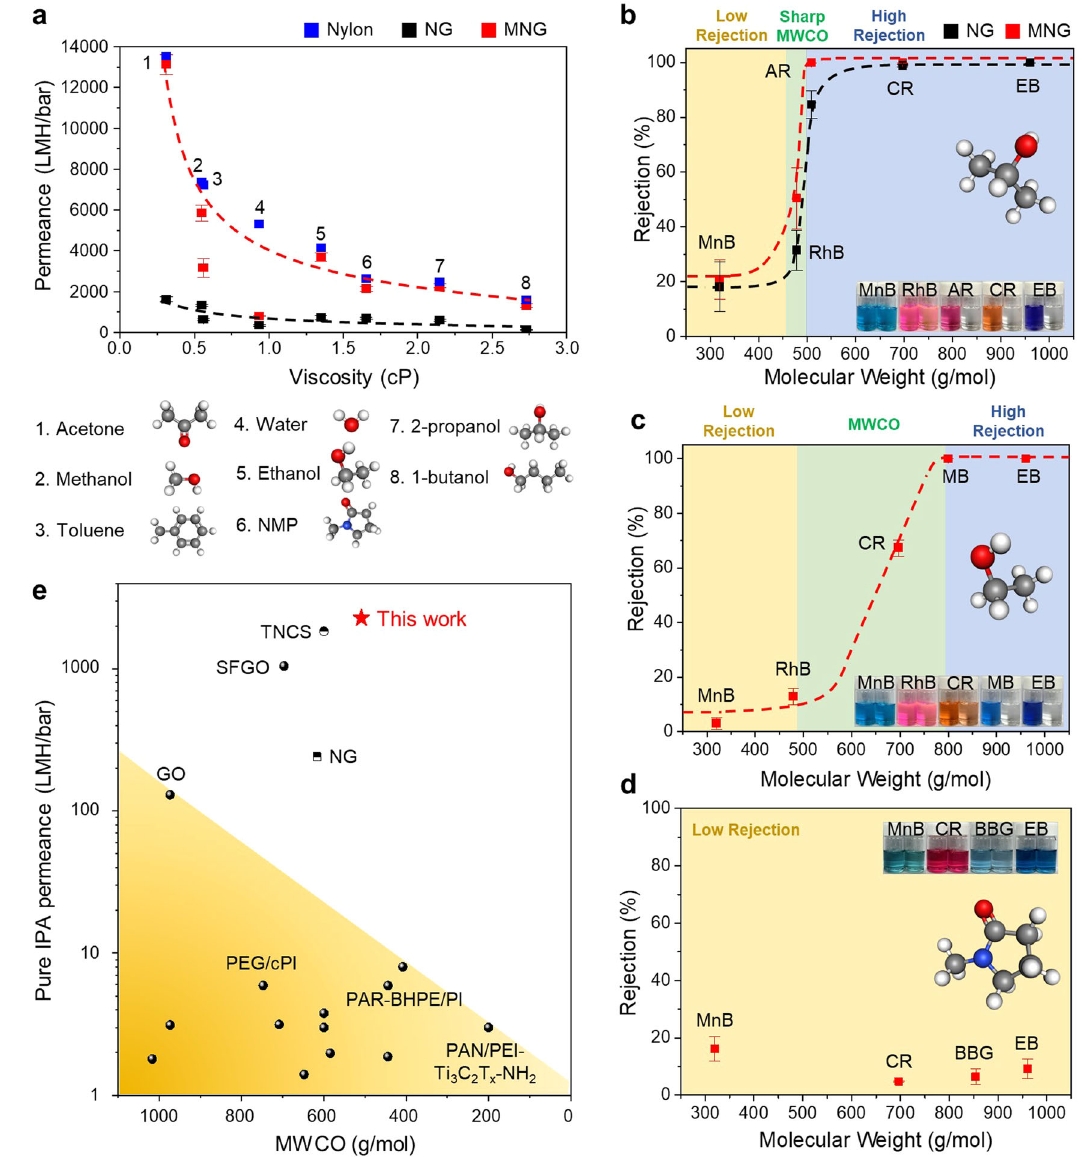
Fig. 5 | Organic solvent nano fi ltration performance of MNG membrane. a Permeance of pure organic solvents across 200nm thick NG and MNG mem- branes as a function of viscosity. b – d Nano fi ltration performance of MNG mem- branestestedwithseveralorganicsolventsanddyemoleculesincludingmethylene